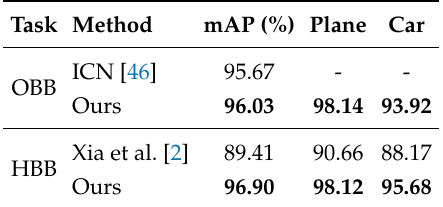
Table 5. Result comparisons on UCAS AOD dataset.